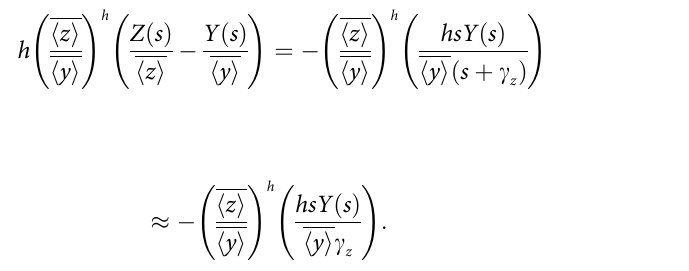
¼ 0 : 25 , CV 2 ¼ 0 : 1 , CV 2 ¼ 0 : 7 , g ¼ 1 g , γ z = 3 γ y . While x y int Z X 5 , the noise contribution from the sensor increases. In d Z